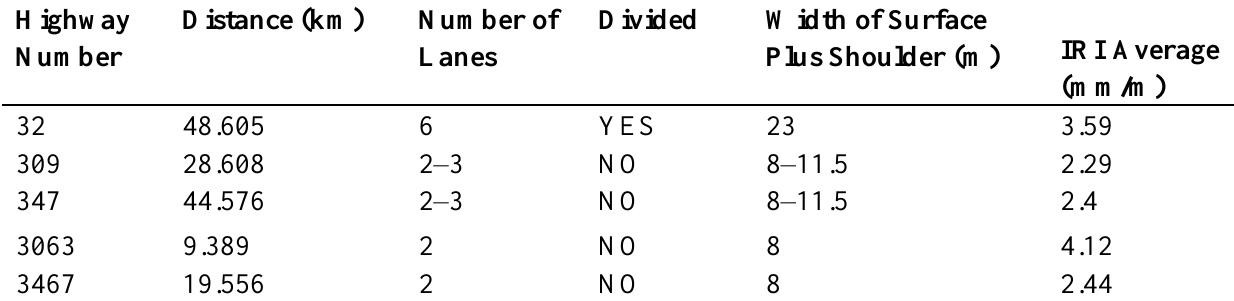
Table 1. Characteristics of the asphalt highways sampled that were the responsibility of the Ayutthaya DOH in